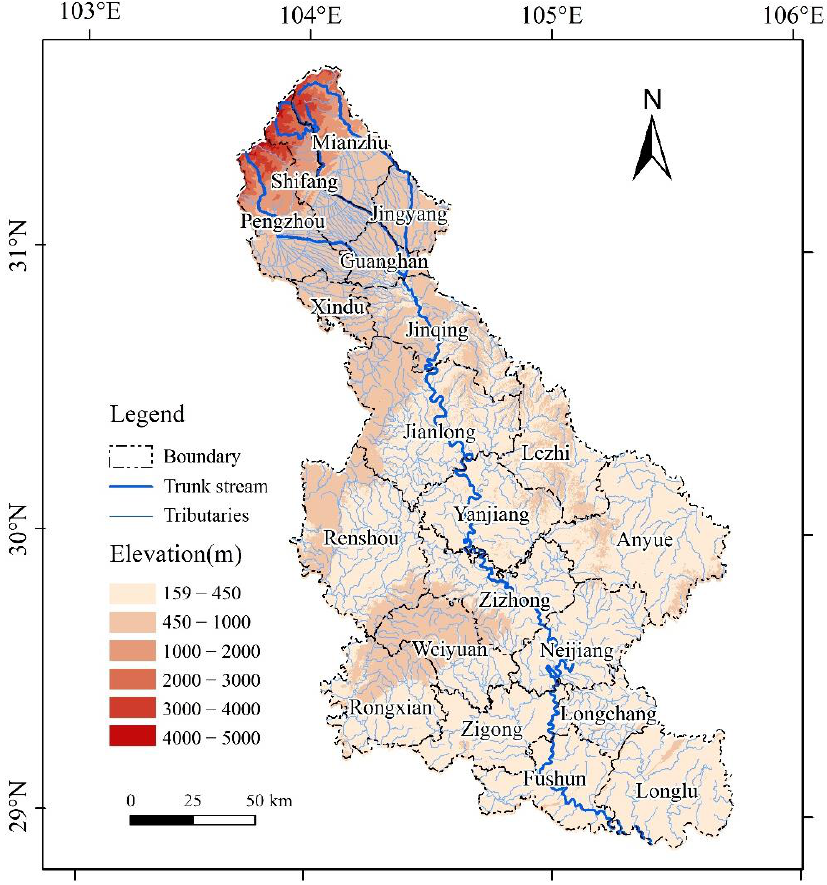
Figure 1. The location of the Tuojiang River Basin.